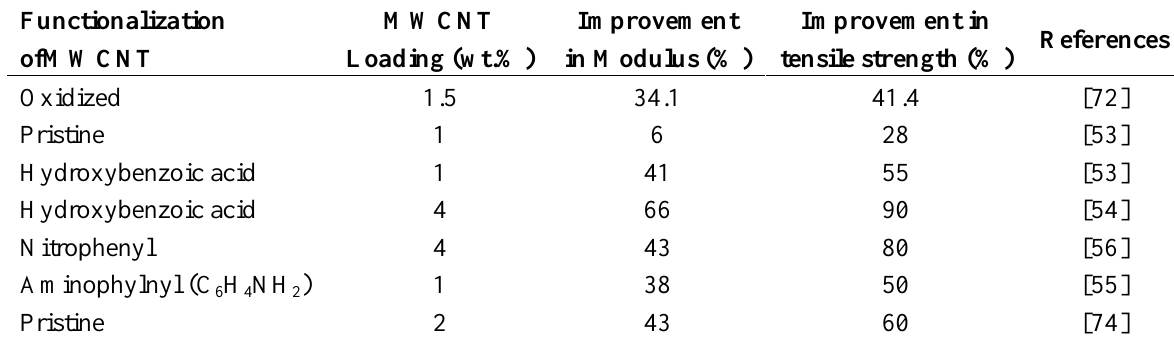
Table 4. Mechanical Properties of MWCNT/TLCP